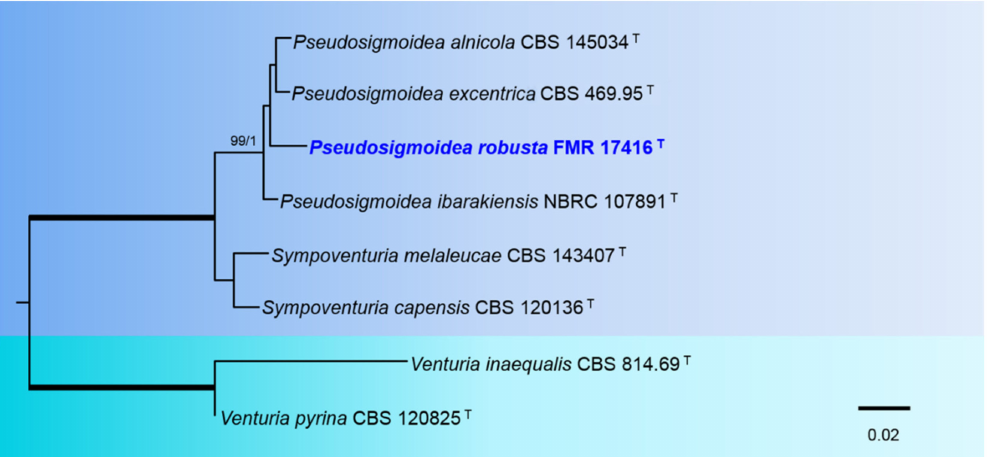
Figure 7. Phylogenetic tree inferred from an ML analysis based on a concatenated alignment of ITS, and LSU sequences of eight strains representing species in the Sympoventuriaceae . The RAxML bootstrap support values (BS) above 70% and the Bayesian posterior probabilities (PP) above 0.95 are given at the nodes (BS/PP). Fully supported branches (100 BS/1 PP) are indicated in thicker lines. Newly proposed taxa are given in blue . Type strains are indicated by a superscript “T”. The tree was